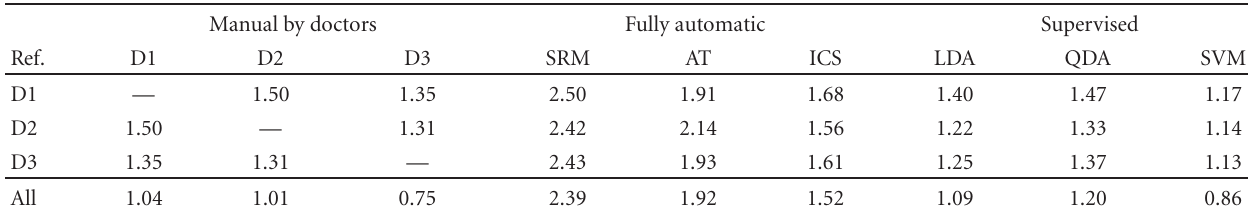
Table 4: Average accuracy of segmentation, quantified by the Hausdor ff distance (mm), showing the performance of the proposed ICS method against alternative solutions. Borders manually drawn by three dermatologists, and their agreement, are considered as the ground- truth reference for accuracy assessment. Manual by doctors Fully automatic